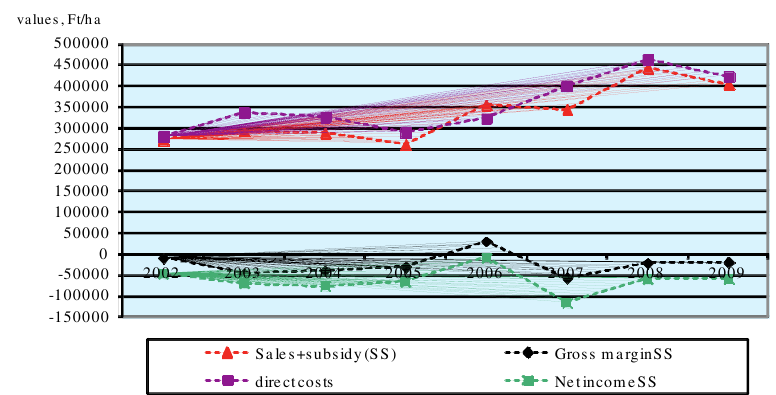
Figure 4. Sales, costs and incomes during the period 2002–2009 in plum production Source: AKI and original